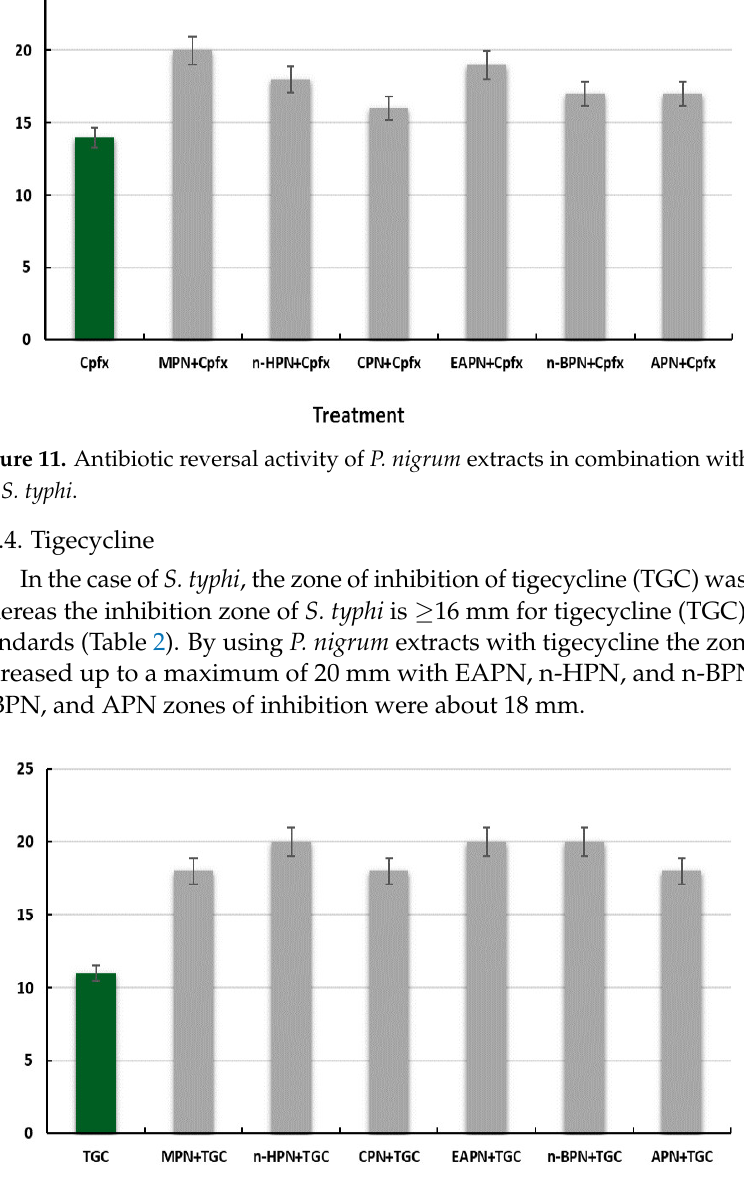
Figure 12. Antibiotic reversal activity of P. nigrum extracts in combination with tigecycline (10 μg) for S. typhi.